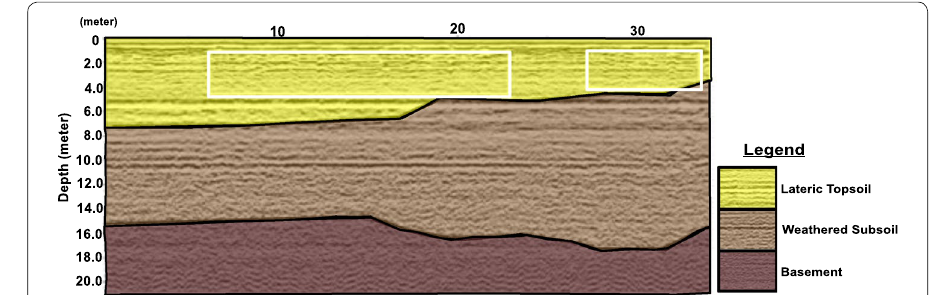
Fig. 25 GPR profile 3 overlaid on Geo-electric section traverse 3